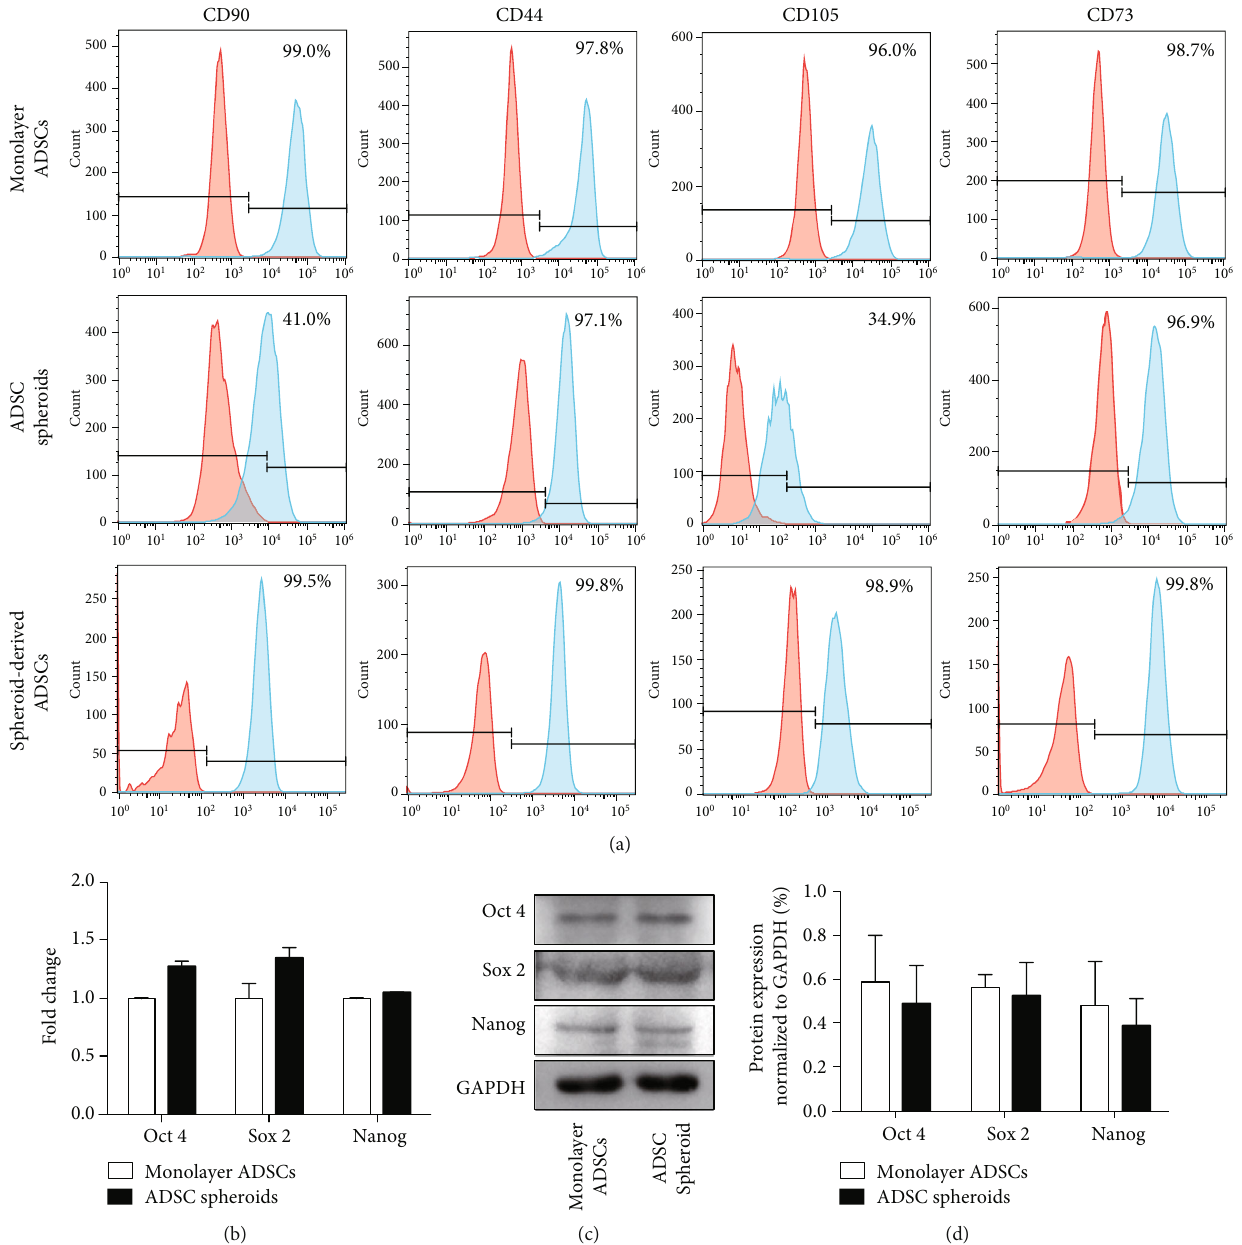
Figure 2: Phenotypic characterization and expression of pluripotent markers in spheroid and monolayer ADSCs. (a) The expression level of MSC surface-speci fi c antigens was determined by fl ow cytometry after 4 days of monolayer and spheroid culture. Spheroid-derived ADSCs were referred to monolayer ADSCs migrated from cell spheroids cultured in serum-containing medium. (b) qPCR measurements for stemness marker genes (Oct 4, Sox 2, and Nanog) in spheroid and monolayer ADSCs. Data are displayed as mean ± SEM . (c) Western blot analysis of the expression of Oct 4, Sox 2, and Nanog in ADSC spheroids and monolayer ADSCs. (d) Quanti fi cation of protein levels compared to GAPDH control. Data are displayed as mean ± SEM